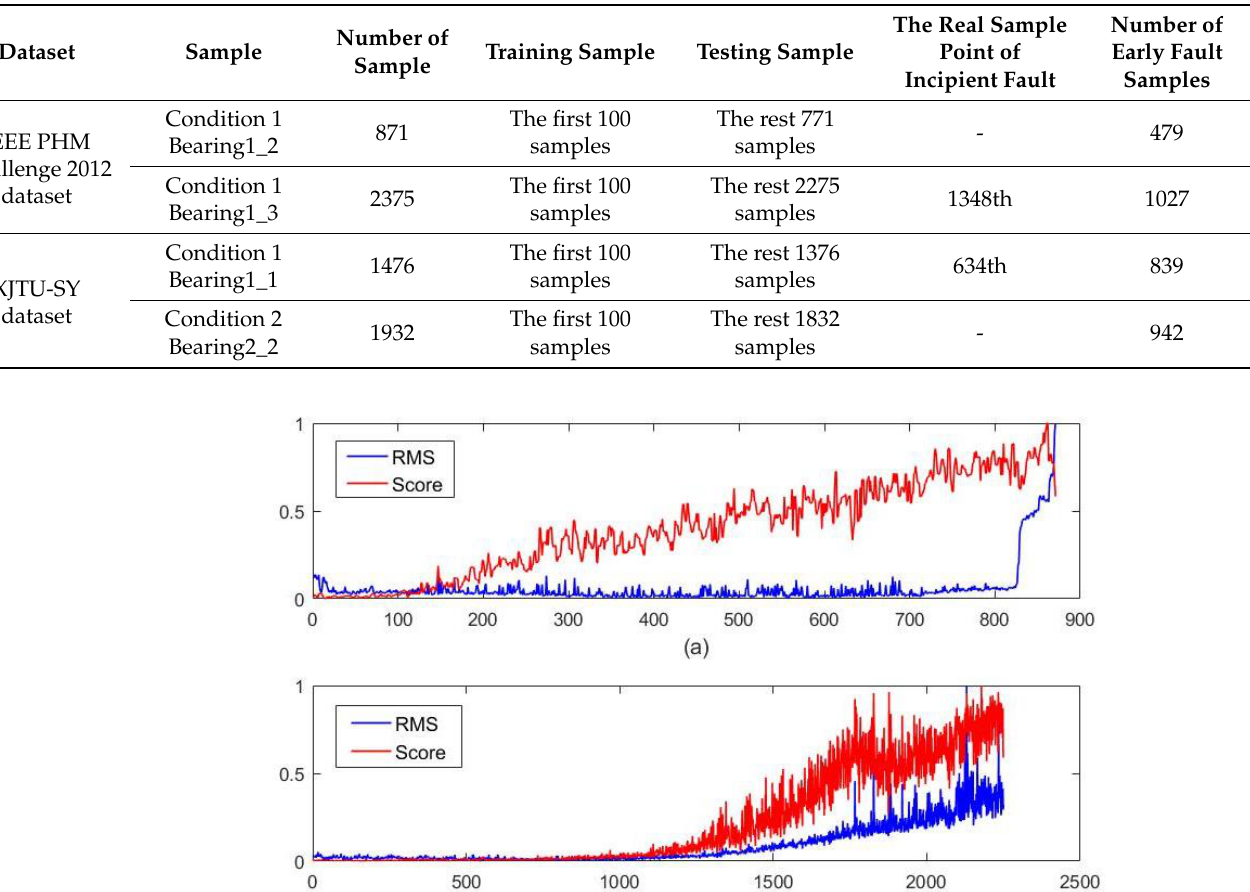
Table 1. Experiment dataset.